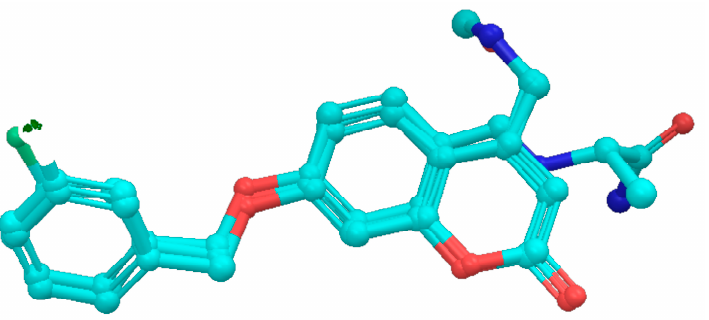
Figure 6. Multi-template conformation of ligand used for shape screening module of Schrodinger- 2022-1.